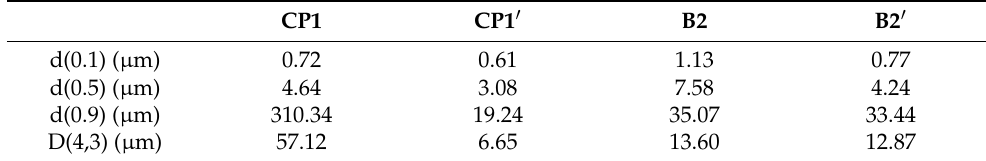
Table 7. Particle size distribution parameters.